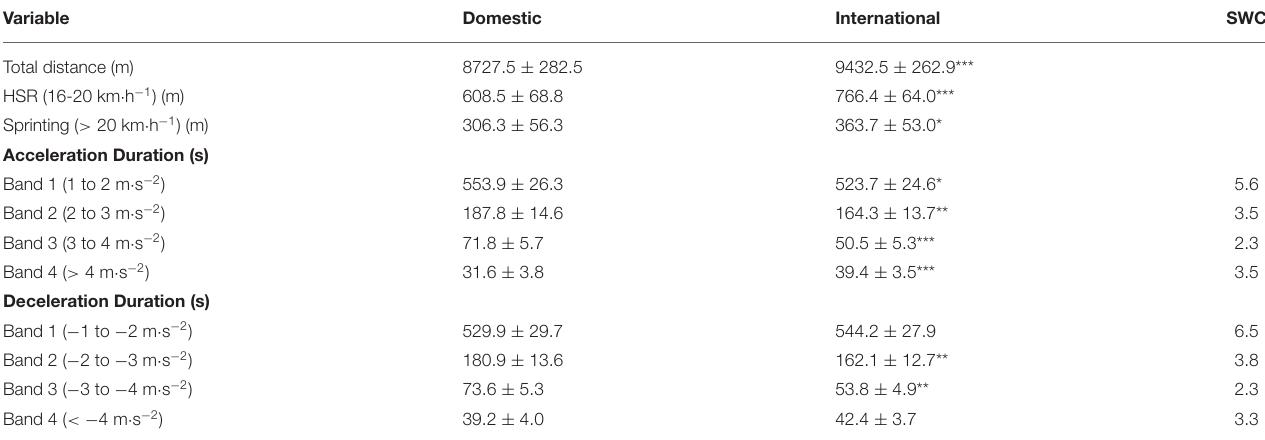
TABLE 1 | Comparison of player movement patterns between domestic and international women’s football.